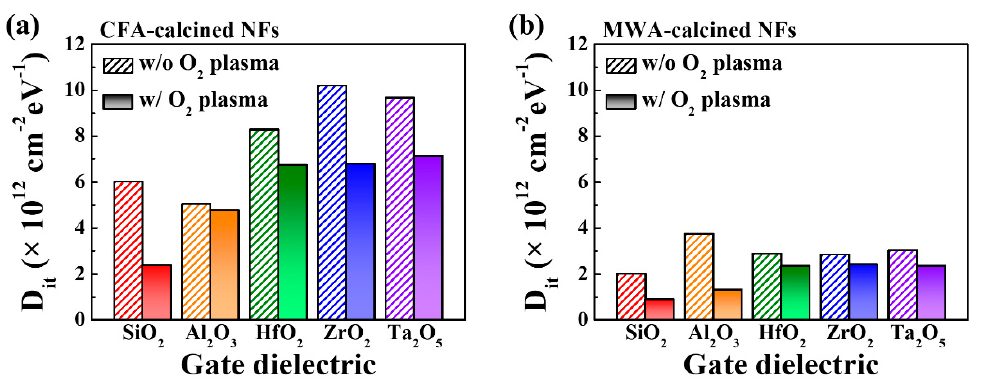
Figure 7. Interface trap density ( D it ) values of ( a ) CFA- and ( b ) MWA-calcined IGZO NF FETs. Dashed and solid bars indicate values obtained before and after postcalcination oxygen plasma treatment, respectively.